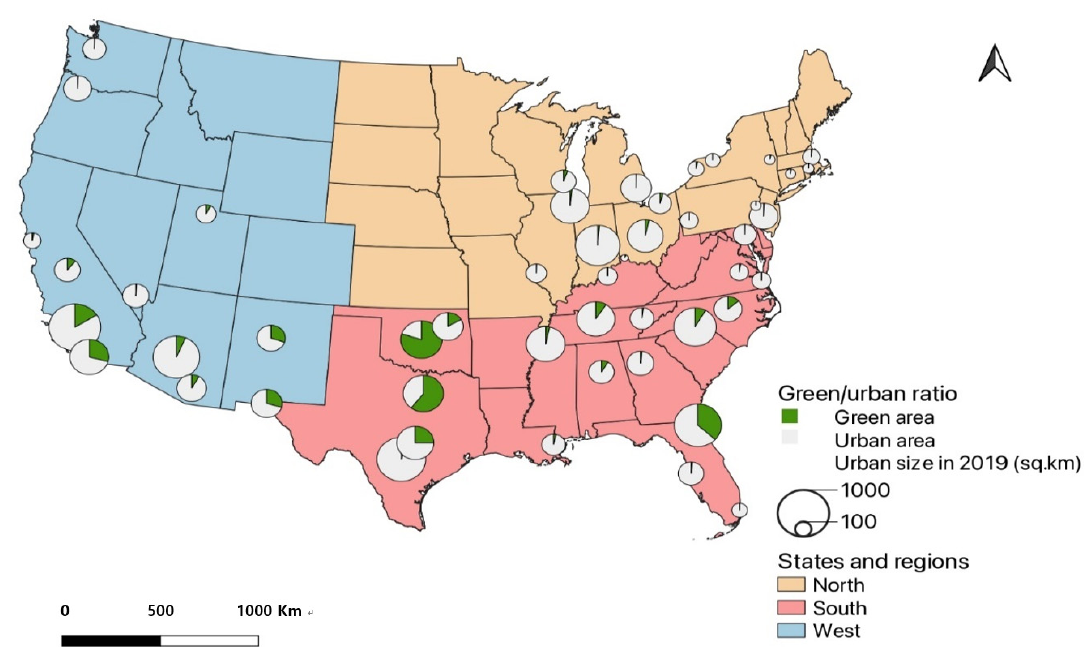
Figure 2. The proportion of urban and green areas in the study area.